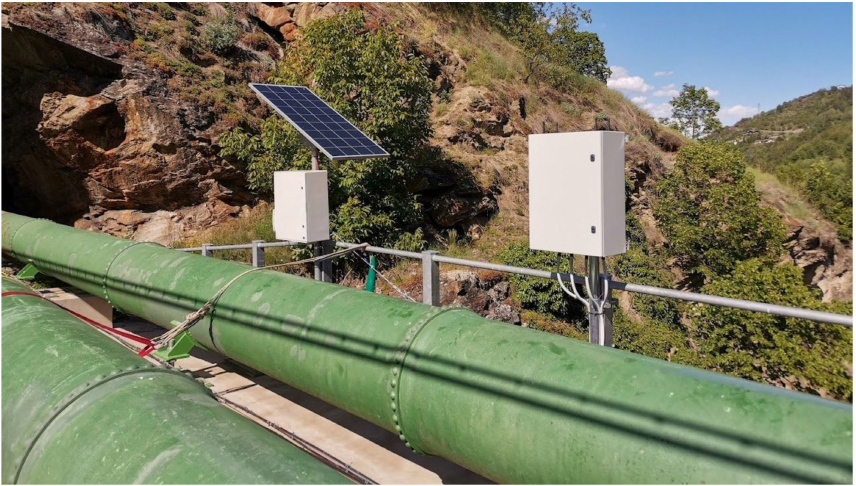
Figure 6. Photography of the power supply system, on the left, and of the wireless sensors node con- trol unit on the right. Data acquired from VW extensometers, temperature probes and accelerometers are collected and transmitted by a